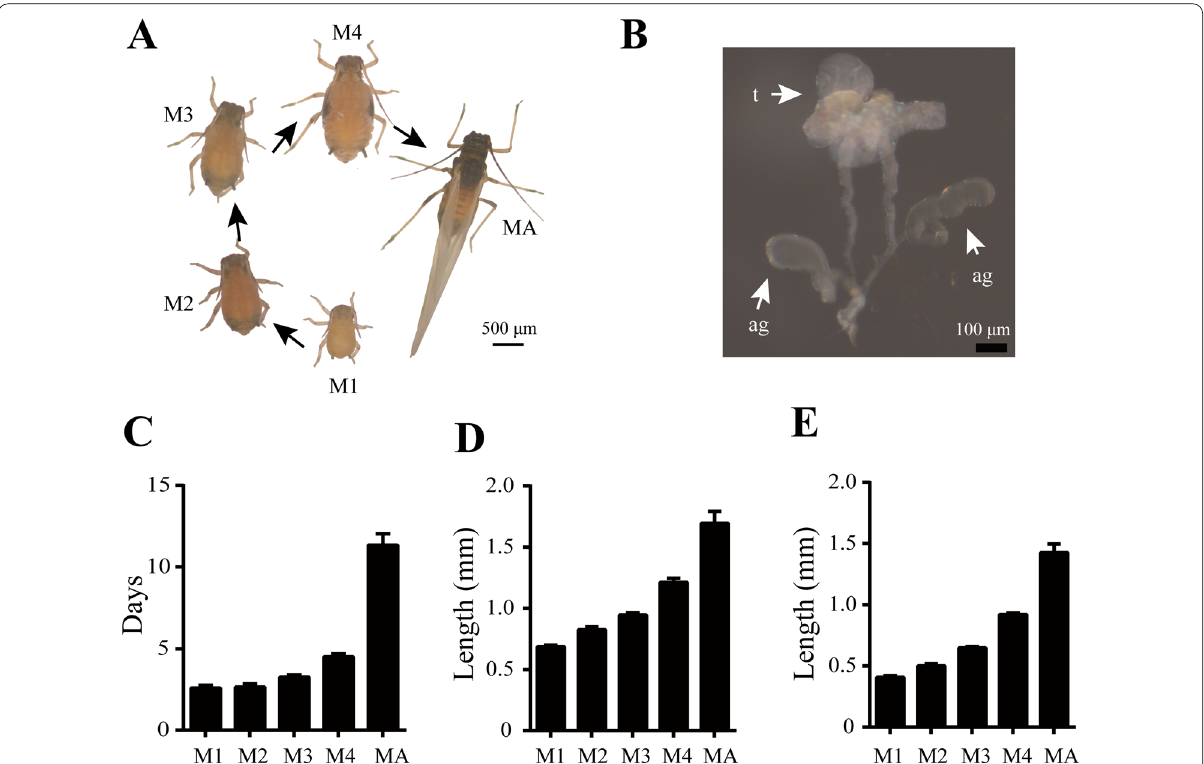
Fig. 2 Morphological changes and biological parameters of male cotton aphid in different developmental stages. A Morphological changes of male cotton aphid. M1, M2, M3, M4 and MA represent the 1st, 2nd, 3rd, 4th instar nymphs and adult, respectively. B Reproduction system of male cotton aphid. C Developmental duration, D Body length, E Antenna length and F Head width of winged male aphid in different developmental stages. Data were showed as mean ±